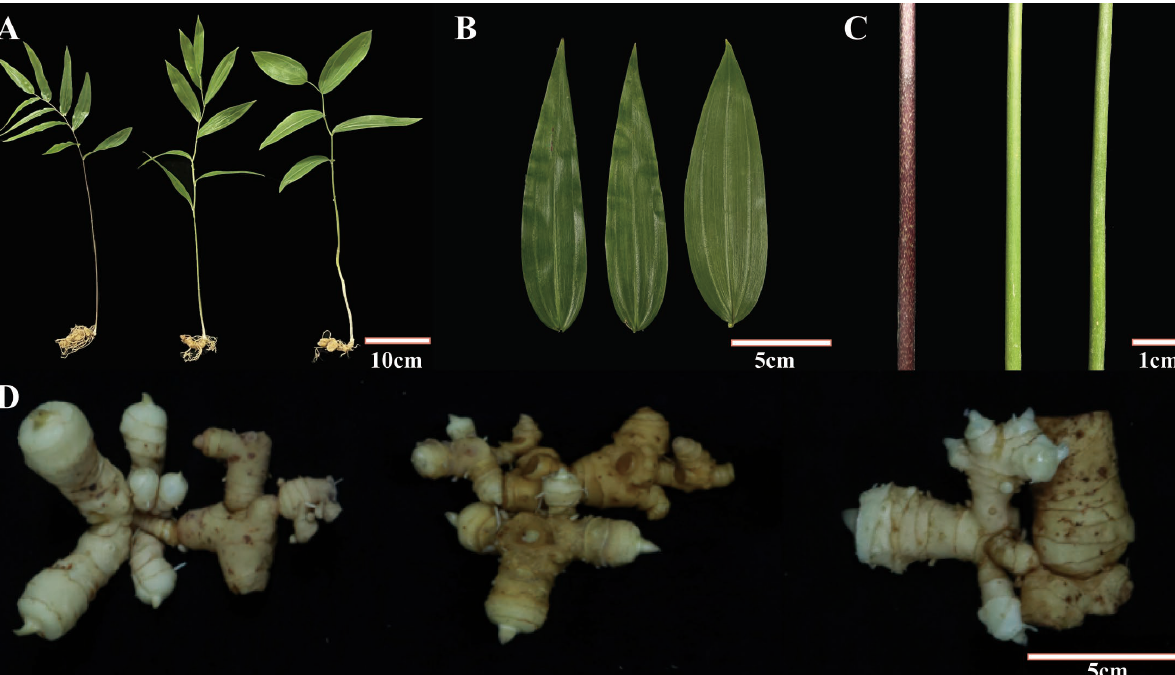
Figure 1. Phenotypic characteristics of different P. cyrtonema germplasm. ( A – D ): From left to right, JZ, JL, and GK